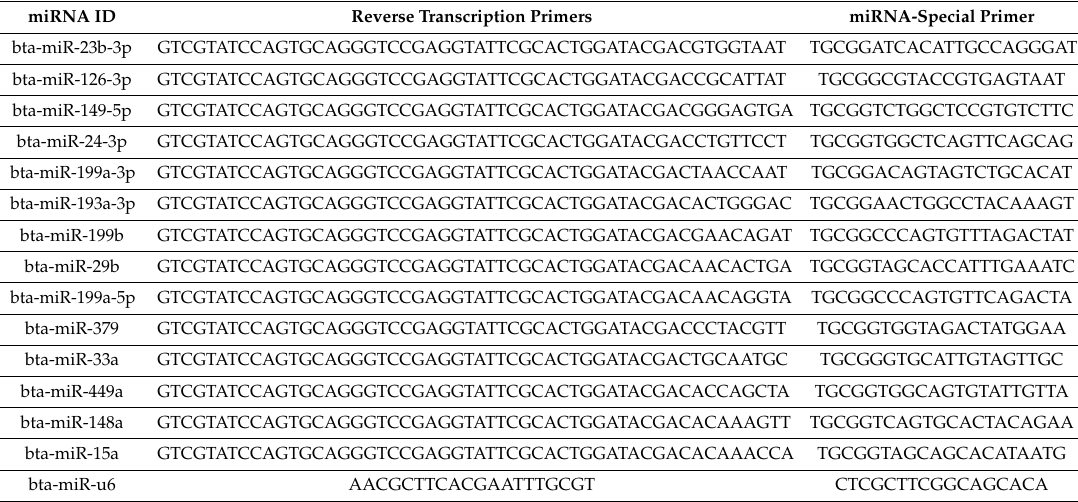
Table 2. miRNA-specific reverse transcription primers.